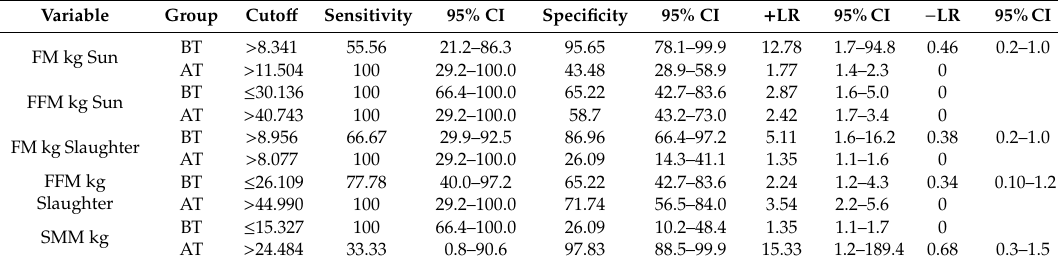
Table 5. Sensitivity and Specificity of body composition variables in Beginner and Advanced Training